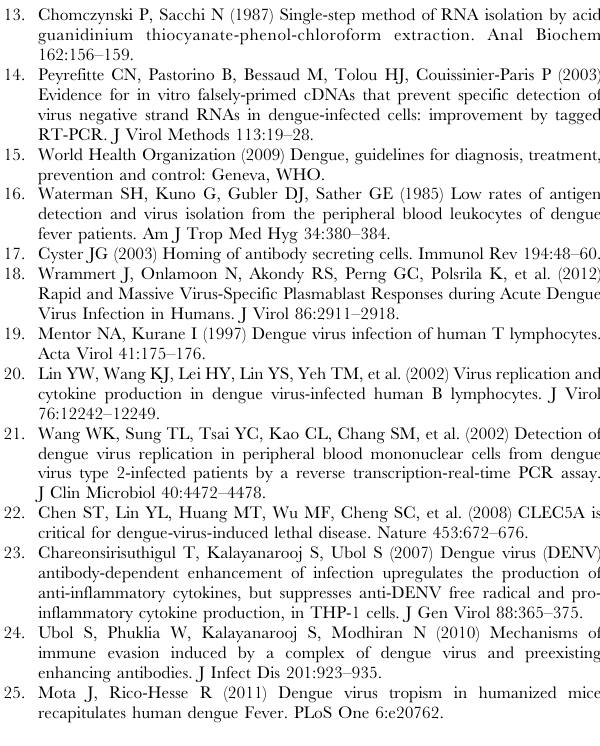
Table S1 Patient characteristics of the all dengue cases enrolled between 1994–2001 and dengue cases selected for this study. Table S2 Patient characteristics of dengue fever (DF) cases with either primary or secondary infection. Table S3 Primers used in positive and negative strand RT-PCR.